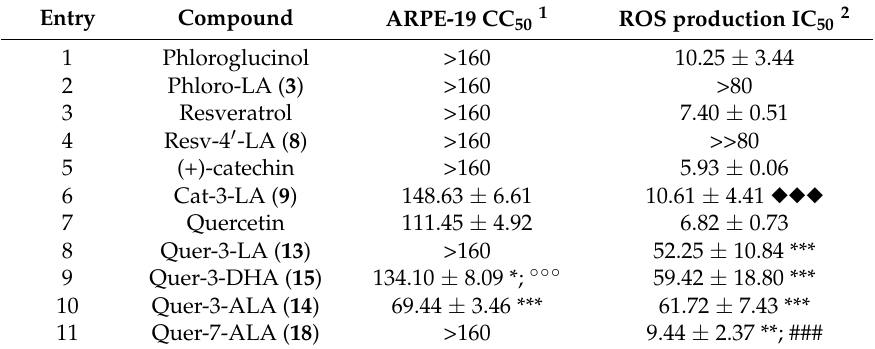
Table 2. Cytotoxicity and antioxidant potential of lipophenols against induced ROS production. Entry